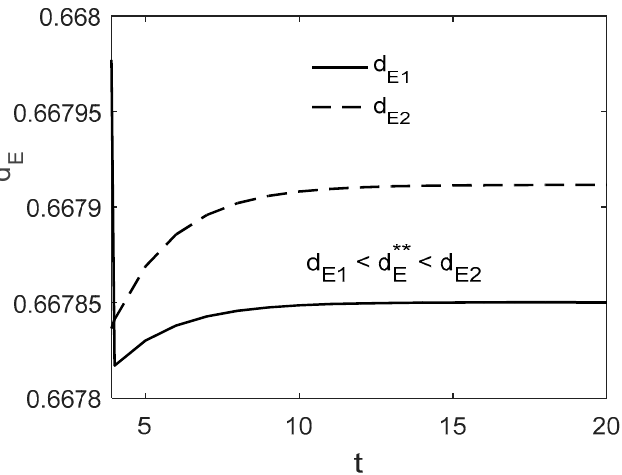
Figure 7. d E ∗∗ that can make the construction enterprise and construction workers mutually beneficial under the combination mechanism.